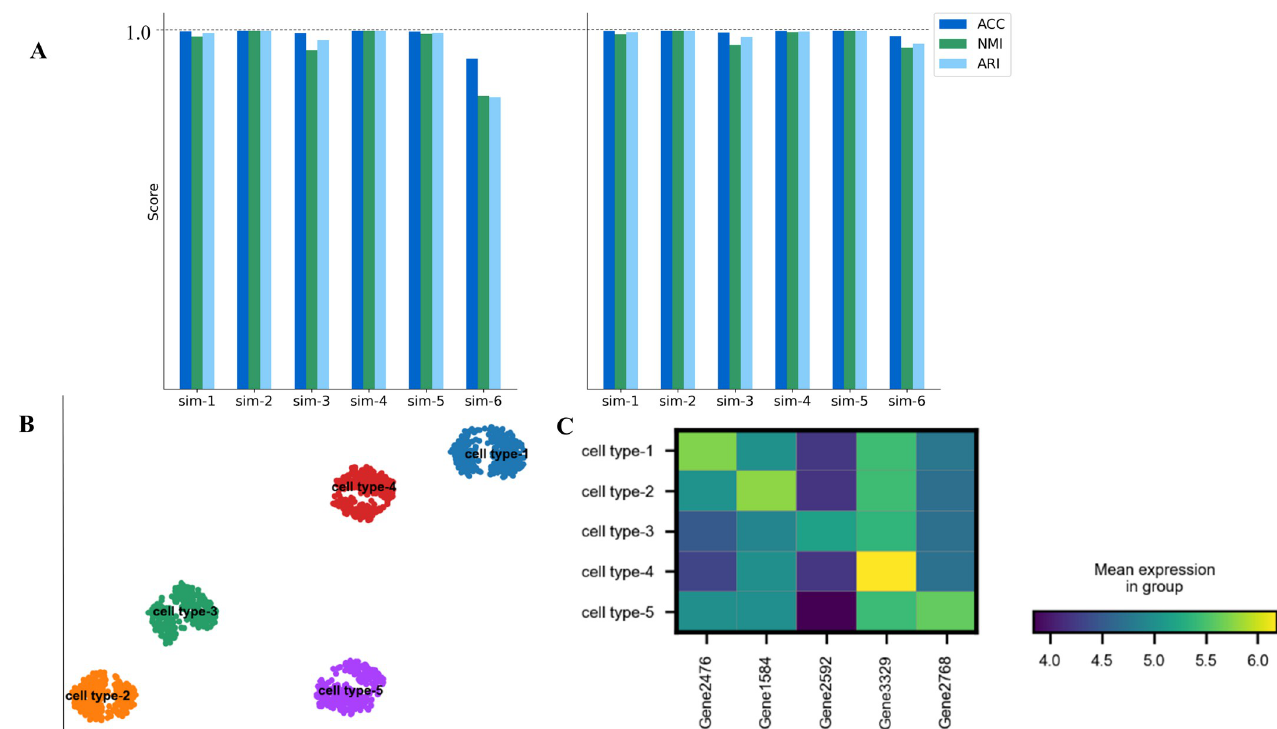
Fig 6. scDSSC is capable on simulation datasets. Plot A shows the clustering performance of scDSSC on 12 simulated datasets. The six datasets in the left panel are generated when the dropout rate is set to 0.25, and the six datasets in the right panel are generated when the dropout rate is set to 0.05. Plot B shows the cell visualization results for one of the datasets with five cell types, corresponding to a dropout rate of 0.25. Plot C shows the differential expression analysis for the dataset used in Plot B. The meanings represented by the rows and columns, as well as the meanings represented by the light and dark colors, are consistent with the results of the differential expression analysis described